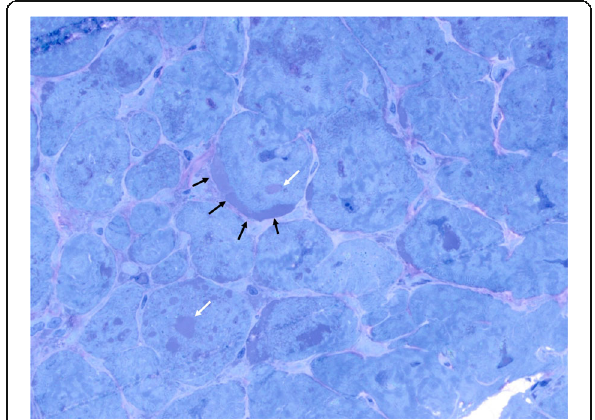
Fig. 1 1 μ m thick section stained with Toluidine blue. Arrows indicate